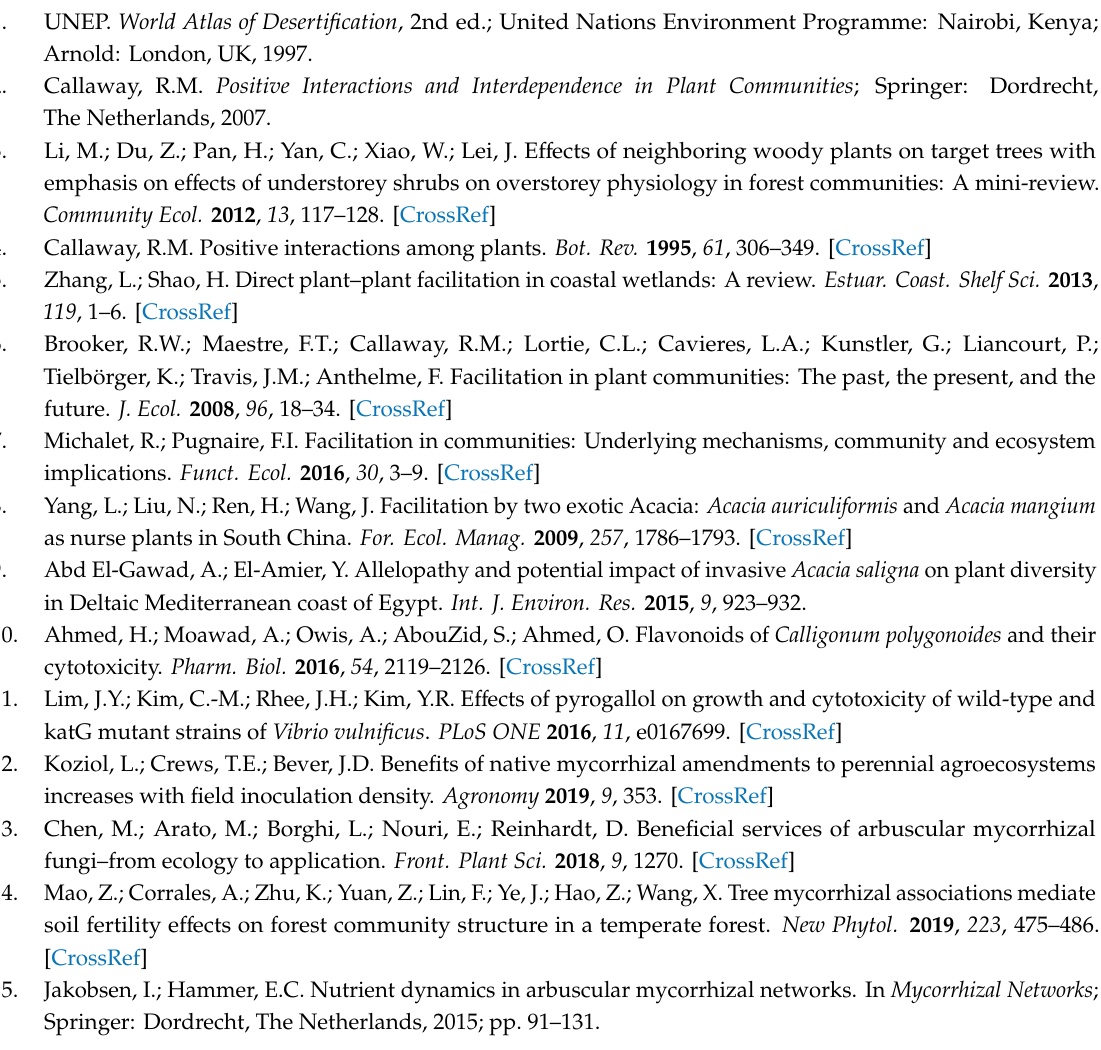
Figure S1: Measurments of C. polygonoides shrubs measurements within the studied locations in the study area, Figure S2: GC-MS chromatograms of the C. polygonoides root extract, Table S1: The plant species composition, families, life forms, chorotypes, and frequency percentage of the recorded species associated with C. polygonoides